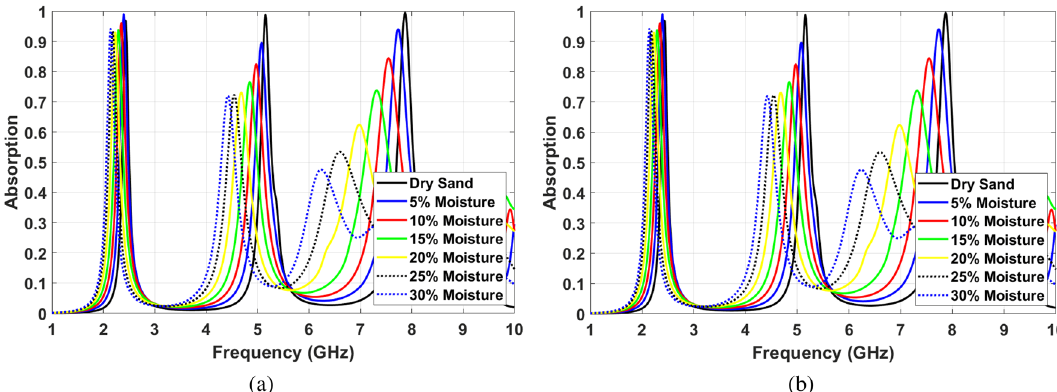
Figure 12. Sensing efficiency of the proposed MPA for different moisture levels in sand soil ( a ) Facing TE polarized incident waves, ( b ) Facing TM polarized incident waves.